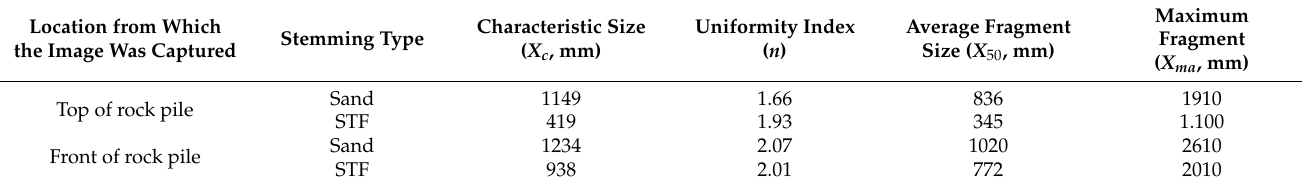
Table 4. Results of rock fragmentation analysis.